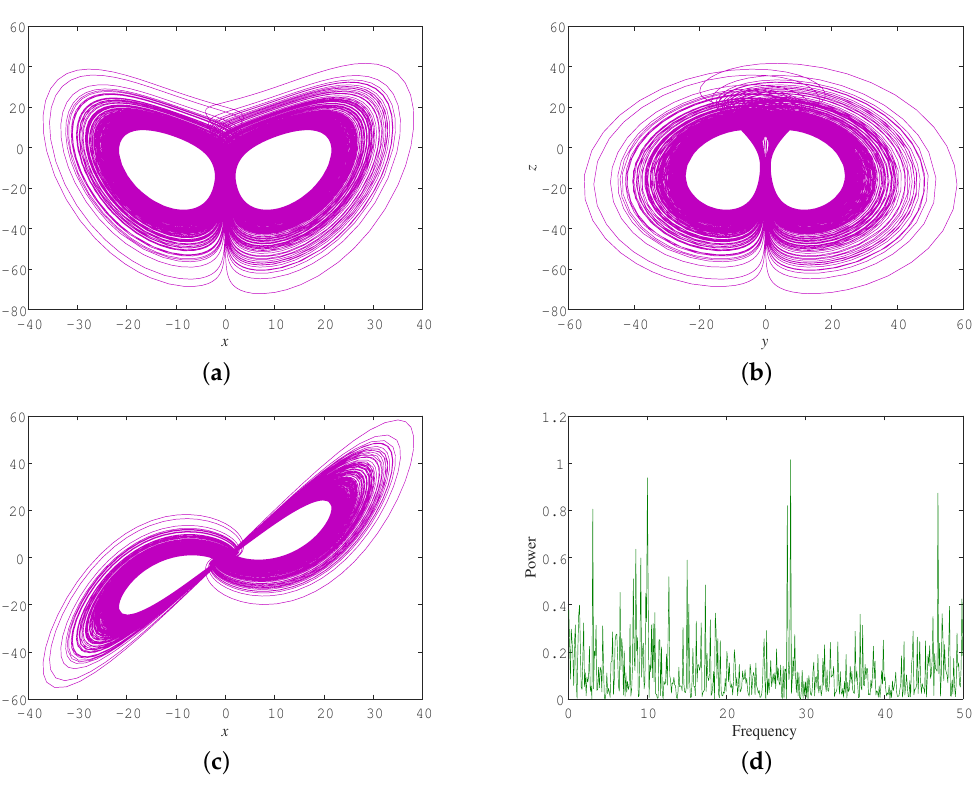
Figure 1. Projections of chaotic attractor onto various planes at time t = 200: ( a ) x – z phase space; ( b ) y – z phase space; ( c ) x – y phase space; ( d ) continuous broadband frequency spectrum.